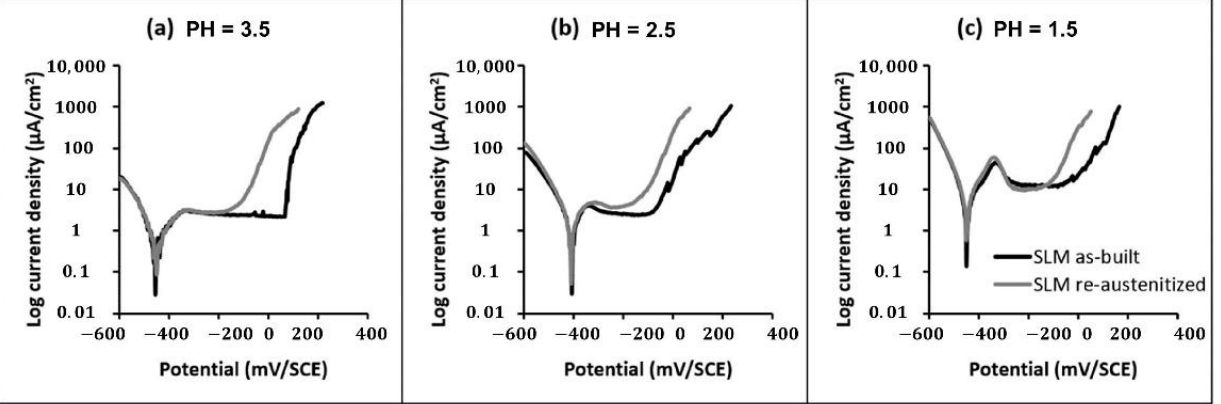
Figure 15. Comparison of the electrochemical behavior of the as-built SLM-ed steel and the re-austenitized SLM-ed steel in NaCl solution at different acid atmospheres: ( a ) pH = 3.5, ( b ) pH = 2.5, and ( c ) pH = 1.5 [150]. (Reprinted with permission from Ref. [150]. Copyright 2020 Elsevier).